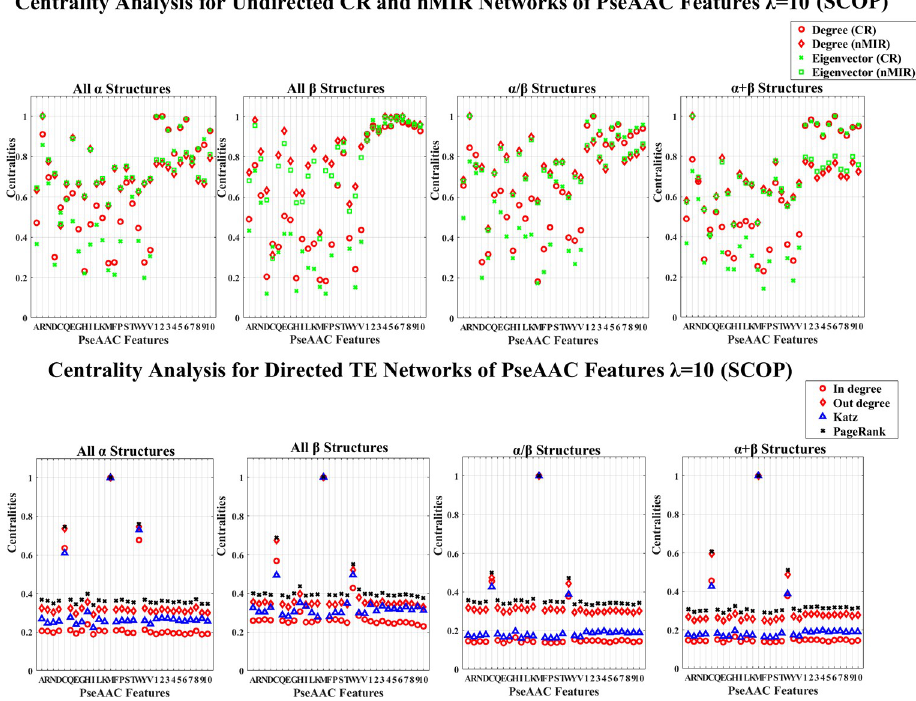
Fig 12. Centrality analysis for the networks of PseAAC features with λ = 10 (SCOP). This figure shows the centrality results for the networks of PseAAC features with λ = 10 (SCOP